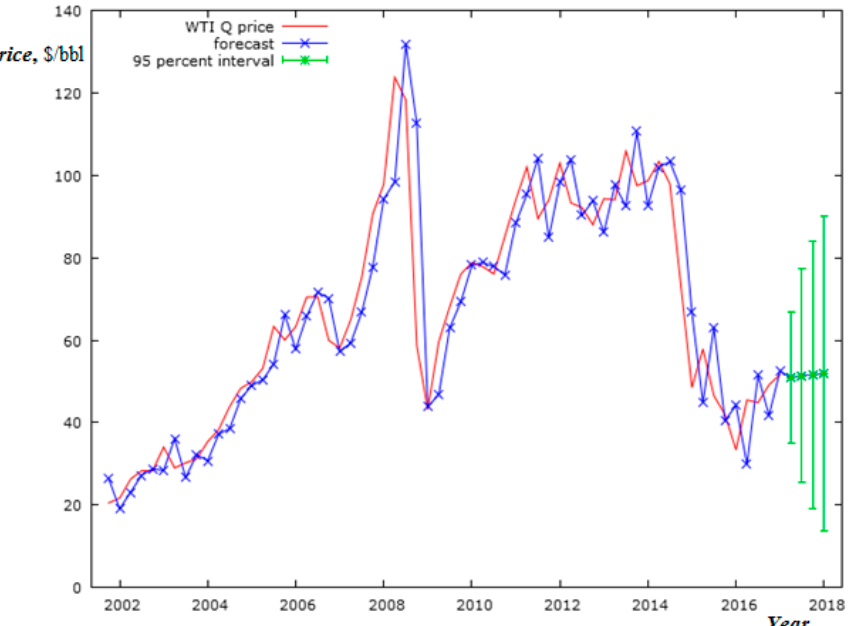
Figure 5. Western Texas Intermediatecrude oil price development and prediction (own compilation).